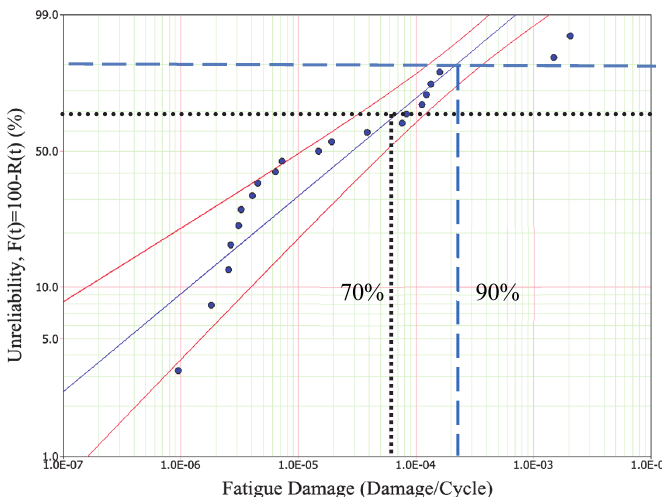
Figure 6: The Weibull probability distribution plots of fatigue damage for